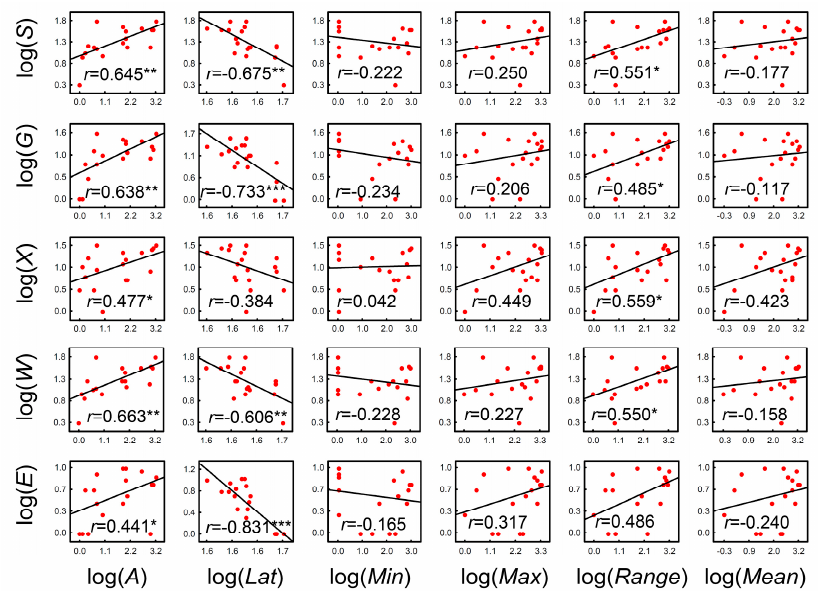
Figure 4. Correlations (Pearson coefficient, r ) between species richness ( S : all species, G : geophilous, X : xylophilous, W : Widespread, E : endemic) and area, latitude, and elevation for tenebrionids in Italian reserves. * = p < 0.05, ** = p < 0.01, *** p < 0.001. A : area (in km 2 ), Lat : Latitude (decimal degrees), Min : Minimum elevation (m), Max : Maximum elevation (m), Range : Elevational range (m), Mean : Mean elevation (m). Table 3. Best-fit models for the influence of area, latitude, and elevation on tenebrionid richness in Italian reserves. DF: degrees of freedom, R 2 adj : adjusted R 2 , AICc: corrected Akaike Information Criterion. Errors refer to standard errors. * = p < 0.05, ** = p < 0.01, *** p <